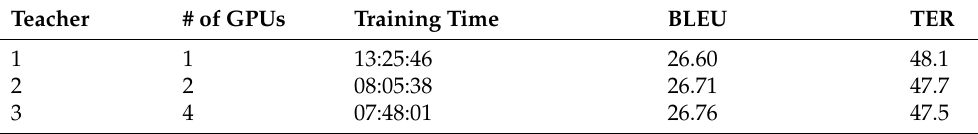
Table 4. Comparison of the performance of the teacher models.